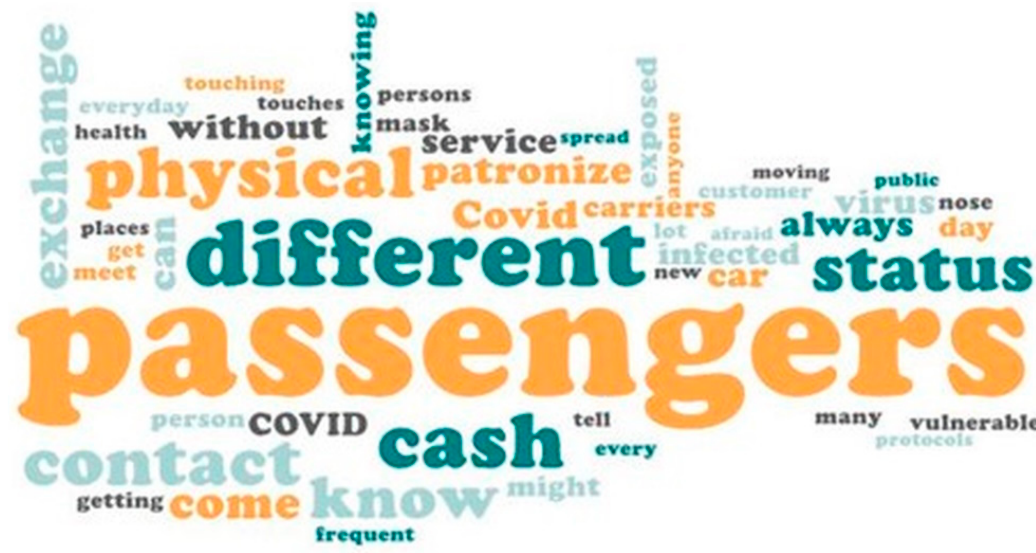
Figure 4. Key factors heightening drivers’ perception of vulnerability.